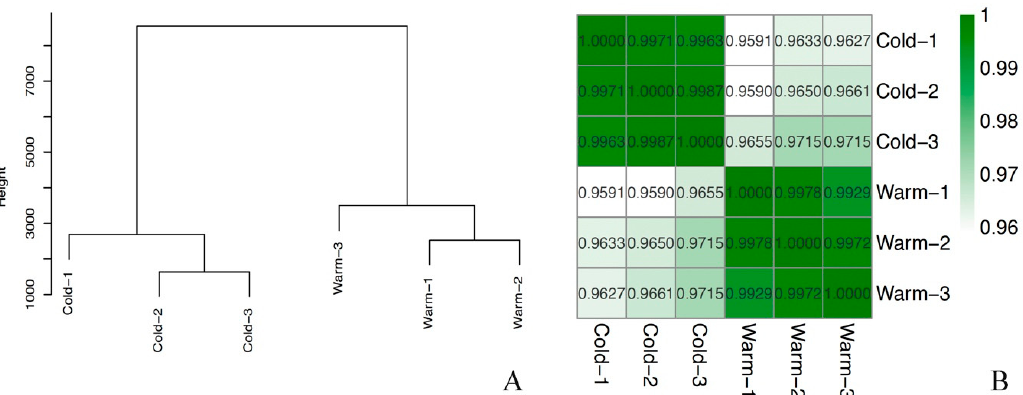
Figure 1. General transcription patterns of all samples ( A ). Clustering of the biological duplicates for each RNA sequencing condition reveals conserved alignment between replicates. ( B ). Pearson correlation between low-temperature-treated and CK nematodes .